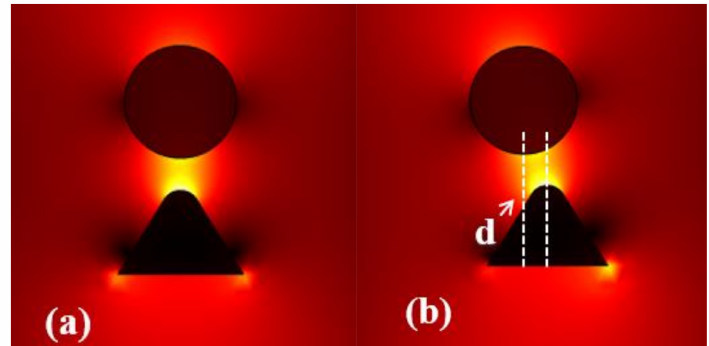
Figure 6. The lateral deviation illustration: ( a ) d = 0 nm; ( b ) d = 20